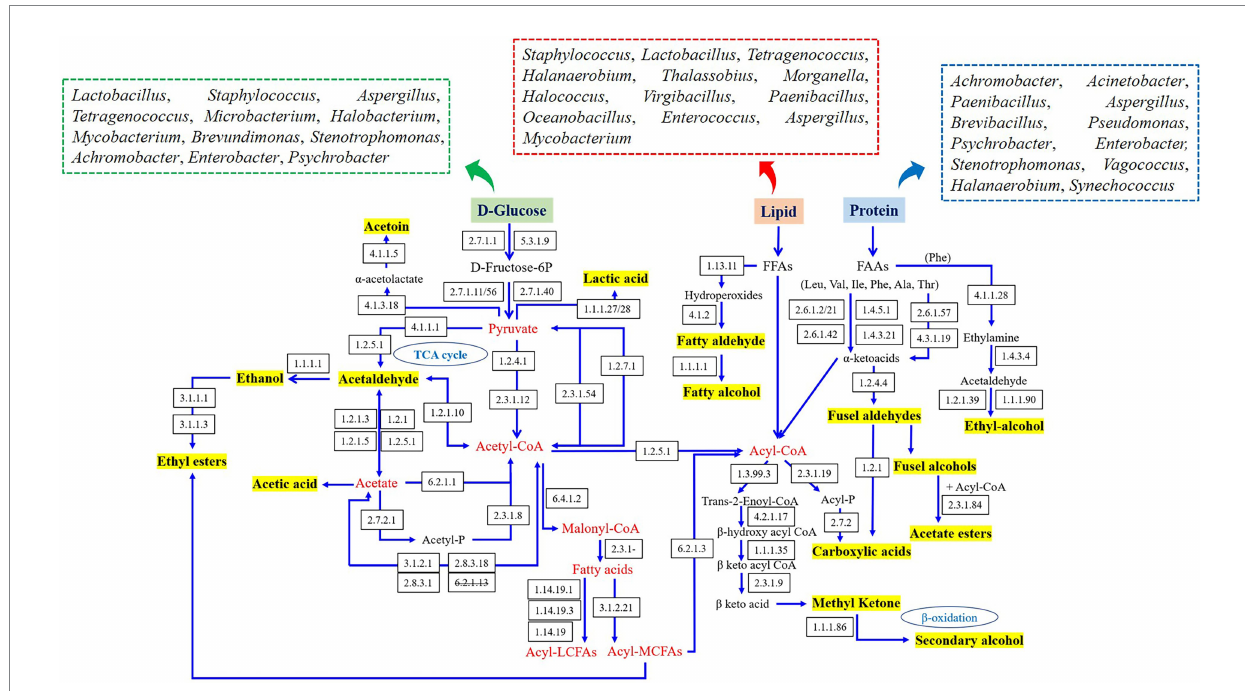
FIGURE 4 Prediction of the metabolic network and related microorganisms in the dominant flavor formation of fish